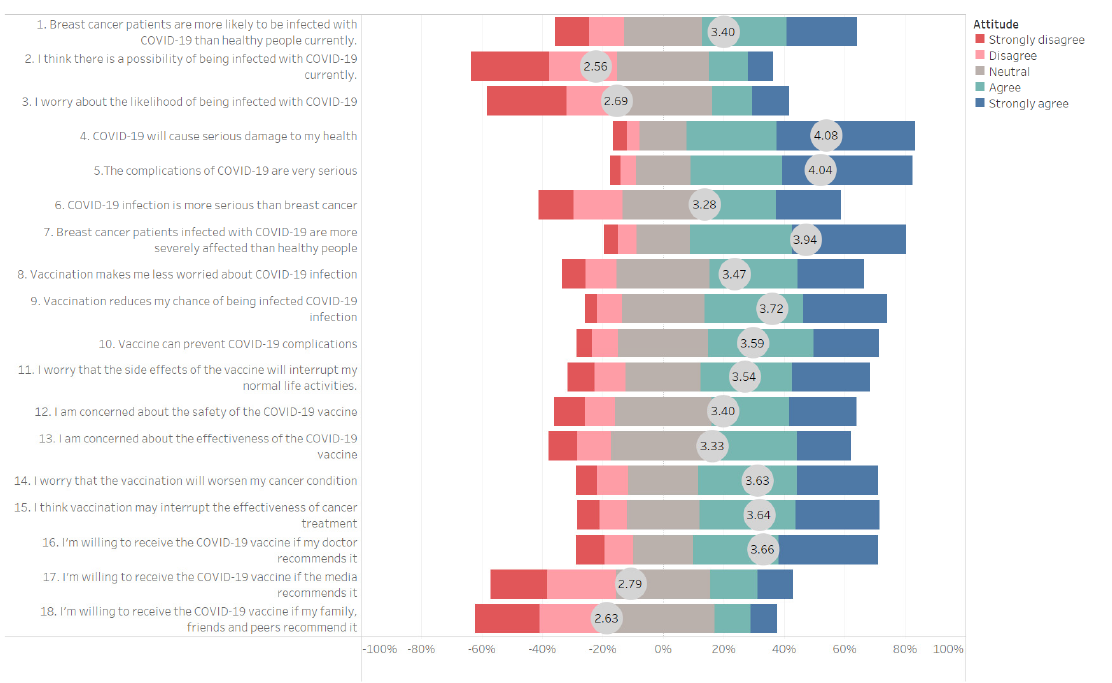
Figure 3. Patients perceived vaccine hesitancy towards the COVID-19 vaccine (Based on Healthy Belief Model).